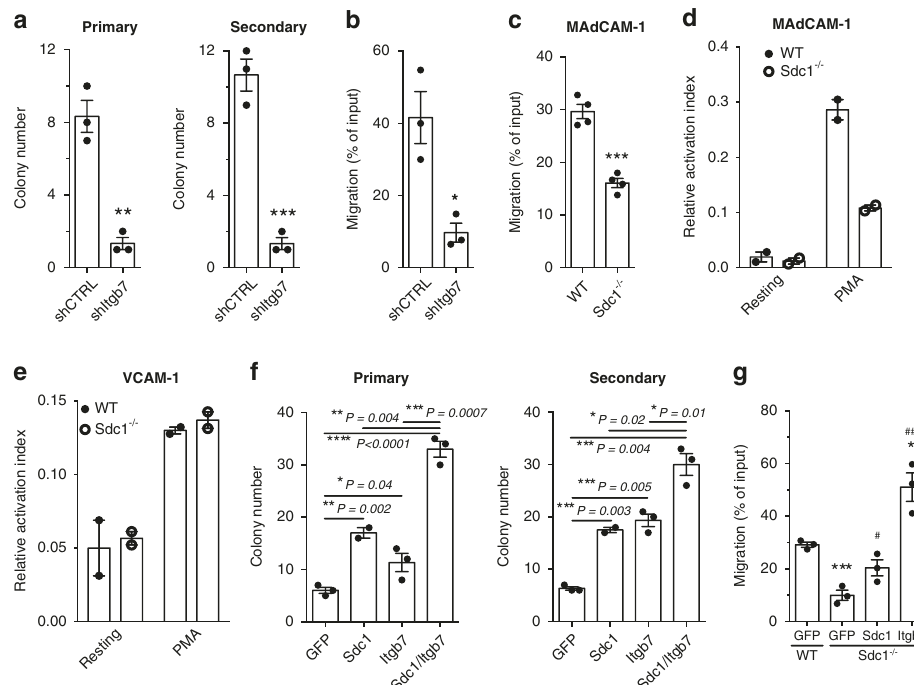
Fig. 9 Syndecan-1 loss impairs integrin β 7 activity. a Number of colonies generated from shCTRL or shItg β 7 knockdown of bcCML cells after the primary (left panel) and secondary plating (right panel). ** P = 0.001, ***P = 0.0006 ( n = 3 technical replicates, representative of 3 biological replicates). b SDF-1 induced migration of shCTRL or shItg β 7 bcCML cells across HUVEC monolayers seeded on fi bronectin-coated transwell fi lters. * P = 0.01 ( n = 4 technical replicates, representative of two biological replicates). c SDF-1 induced migration of WT or Sdc1 − / − bcCML cells across MAdCAM coated transwell fi lters. *** P = 0.0002 ( n = 4 technical replicates, representative of two biological replicates). d Soluble ligand binding assay with WT and Sdc1 − / − bcCML and the Itg β 7 ligand, MAdCAM-1, either resting or stimulated with 200 nM phorbol myristate acetate (PMA). Data are normalized to non-physiological stimulation with 1 mM Mn 2 + ( n = 2 technical replicates, representative of two biological replicates). e Soluble ligand binding assay with WT and Sdc1 − / − bcCML and the Itg β 1 ligand, VCAM-1, either resting or stimulated with 200 nM PMA. Data are normalized to non-physiological stimulation with 1 mM Mn 2 + . ( n = 2 technical replicates, representative of two biological replicates). f Rescue of Sdc1 − / − primary and secondary colony formation by ectopic expression of either empty GFP control, wild-type Sdc1, Itg β 7 or Sdc1 + Itg β 7. ( n = 3 technical replicates, representative of three biological replicates). g Rescue of Sdc1 − / − migration on FN coated fi lters by ectopic expression of either empty GFP control, wild-type Sdc1, or Itg β 7. * P = 0.02, *** P = 0.0009, # P = 0.04, ## P = 0.002. *Signi fi cance from WT bcCML + empty GFP, #signi fi cance from Sdc1 − / − + empty GFP ( n = 3 technical replicates, representative of